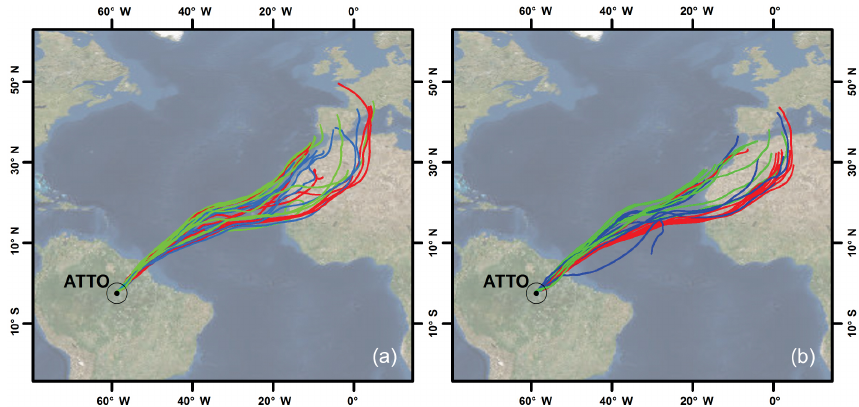
Figure 1. Backward trajectories of air parcels above the Amazon for 240h during the sampling periods for (a) 5 April 2015 and (b) 6 April 2015, when the greatest concentrations of dust from the Sahara arrived at ATTO.